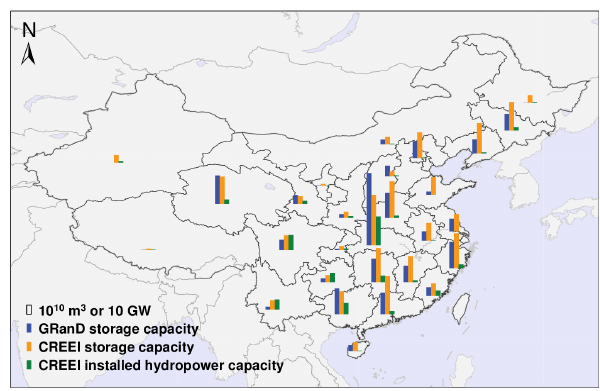
Figure 1. Reservoir storage capacity and IHC at the provincial level in mainland